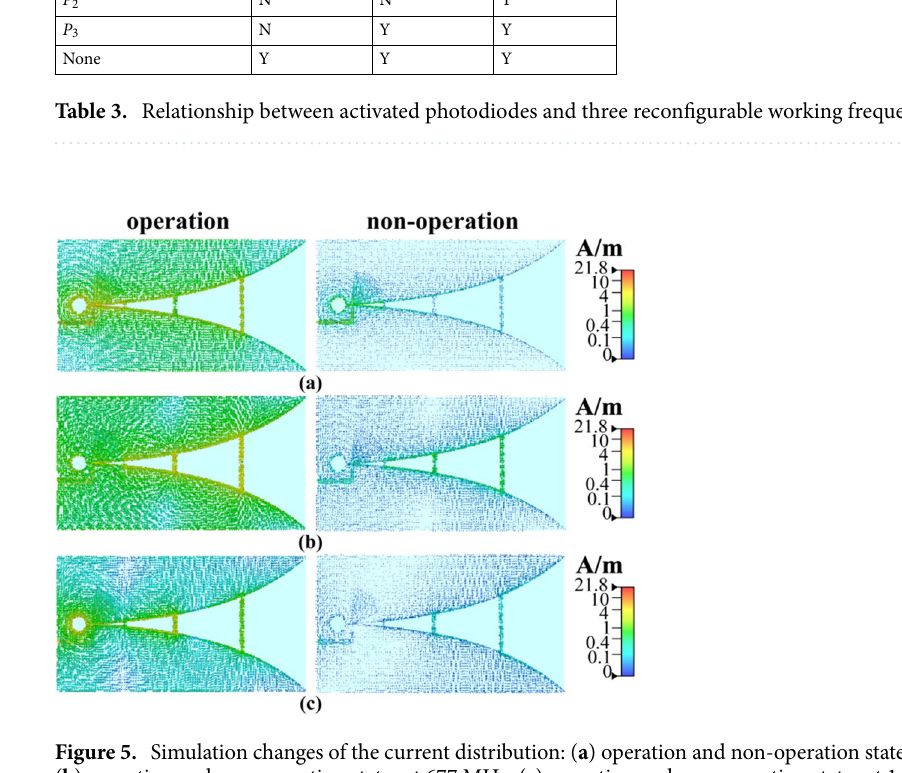
Figure 5. Simulation changes of the current distribution: ( a ) operation and non-operation states at 300 MHz; ( b ) operation and non-operation states at 677 MHz; ( c ) operation and non-operation states at 1.02